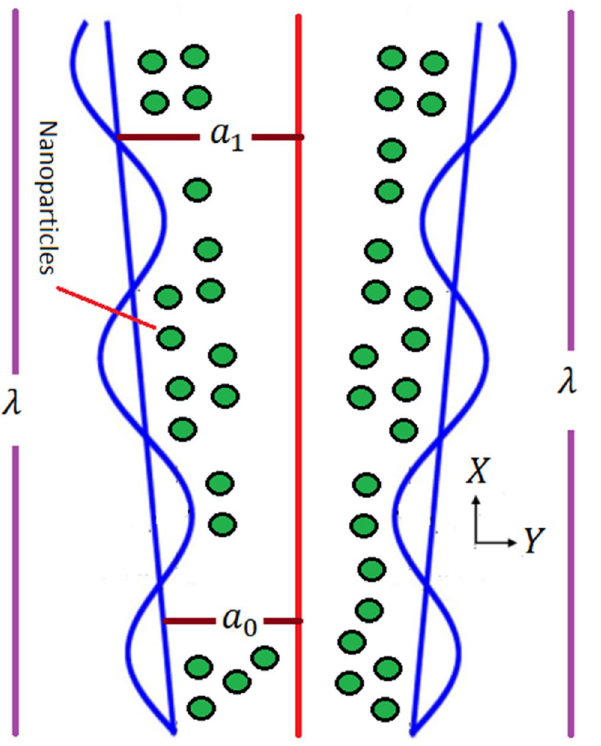
Figure 1. Problem’s